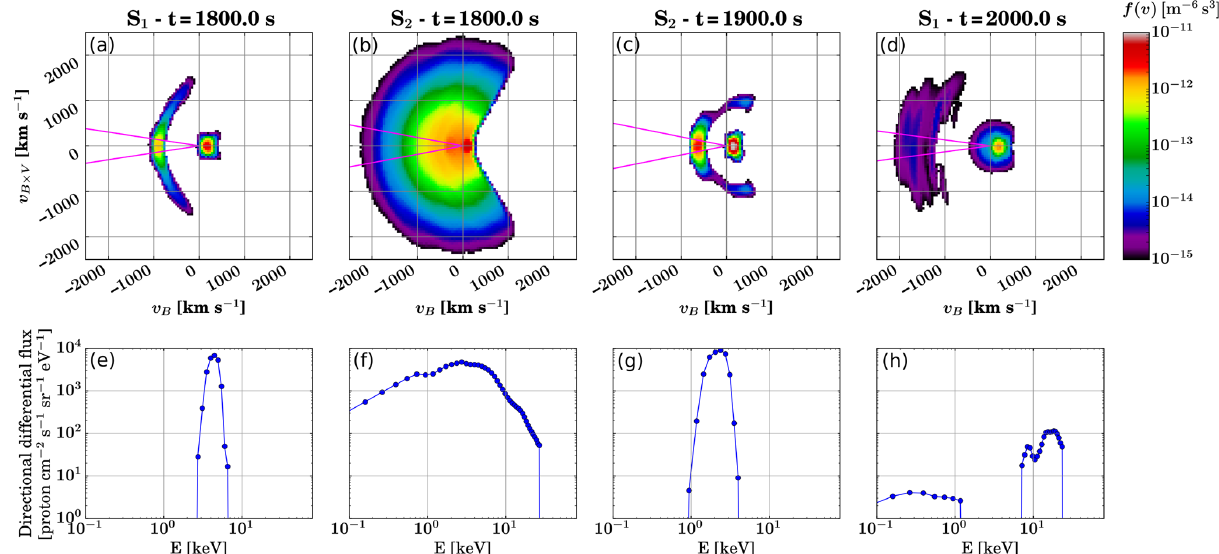
Figure 4. (a, b, c, d) Examples of proton velocity distribution slices in the local magnetic frame at virtual spacecraft S 1 and S 2 at various time steps of the simulation. The bounce loss cone is shown with magenta lines. (e, f, g, h) Corresponding directional differential precipitating fluxes obtained with the presented